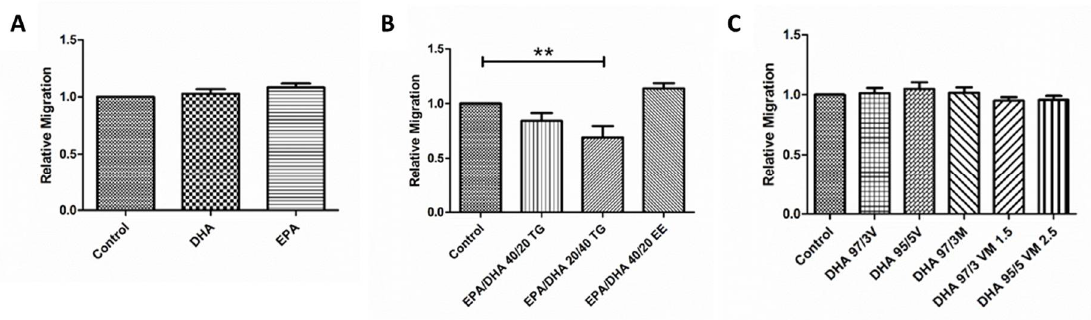
Figure 6. Graphs showing relative migration ratio ( A–C ) results for ARPE-19 cells treated with different groups 1, 2, and 3 of DHA/EPA formulations, respectively. For comparisons, one-way ANOVA with the Bonferroni post-hoc test were used. Data are expressed as mean ± SEM. ** p < 0.01. EPA: Eicosapentaenoic acid; DHA: Docosahexaenoic acid; TG: Triglycerides; EE: Ethylesters; PL: Phospholipids. V: Vegetable. M: Marine.